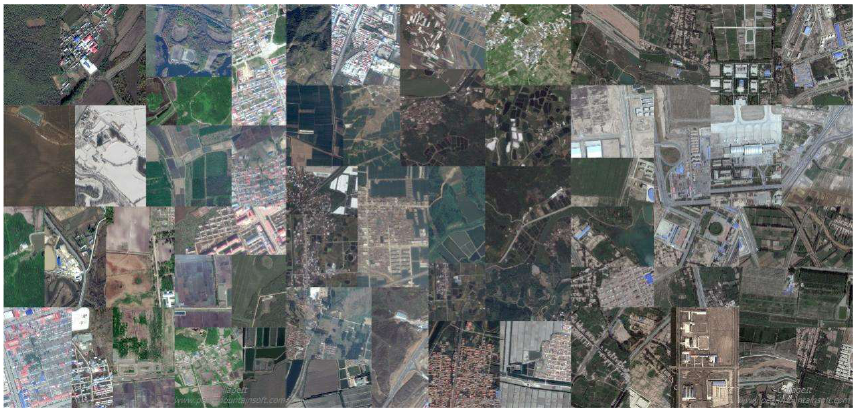
Figure 4. The negative samples of track and fields in China.